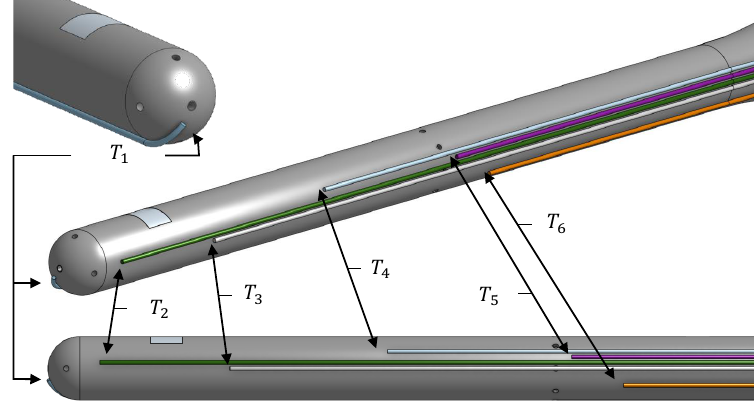
Figure 9. Thermocouples positioning on the probe surface.